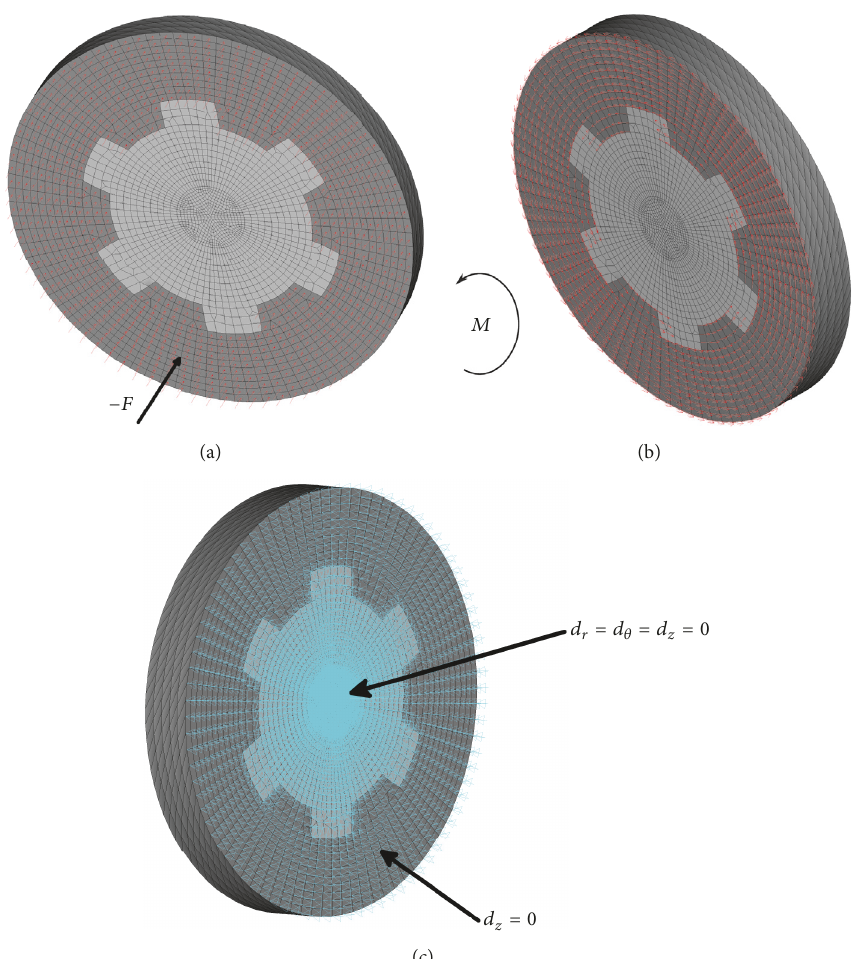
Figure 6: Loads and boundary conditions applied to the FEM model of the helical spline coupling ( 𝛽 = 135 deg): (a) axial force loading (axial section 𝑧 = 𝐿 ), (b) torque loading (axial section 𝑧 = 𝐿 ), and (c) boundary conditions (axial section 𝑧 = 0